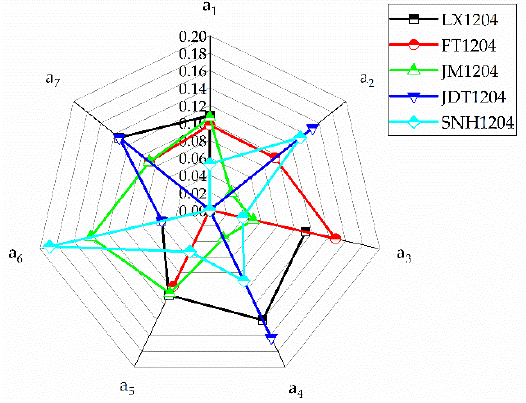
Figure 3. Factor data characteristics.